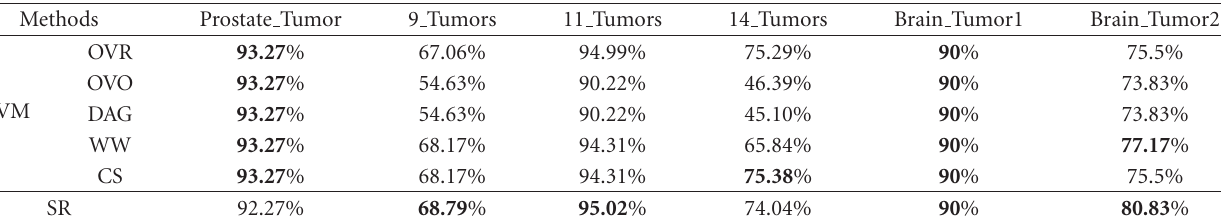
Table 1: Results without gene selection.